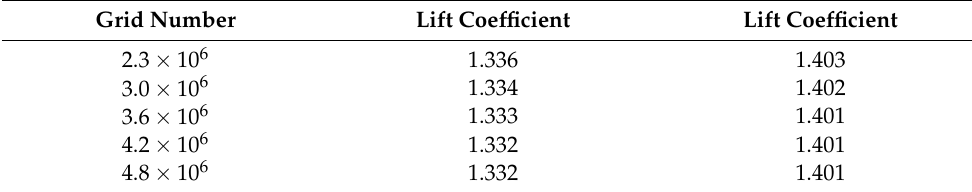
Table 2. Grid independence verification of SCR.